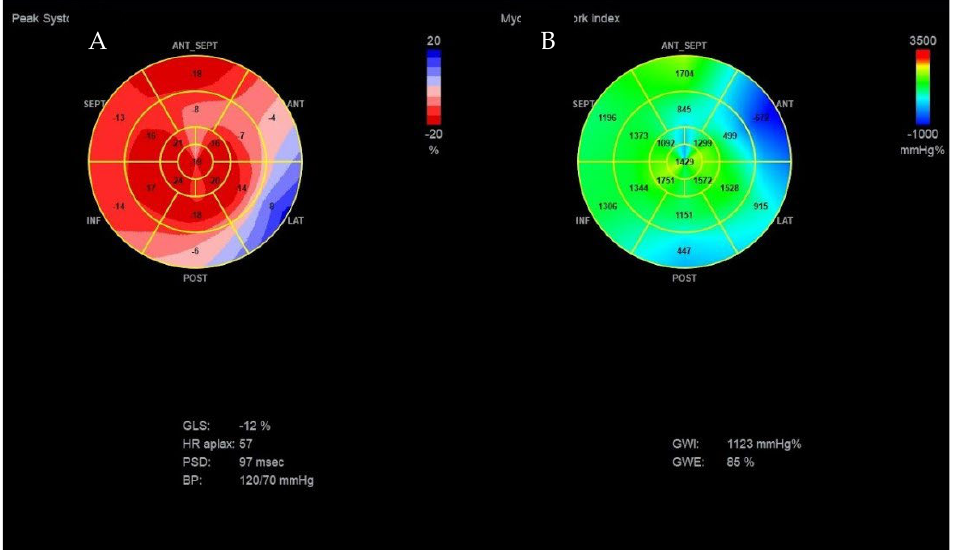
Figure 3. ( A ) Bull’s-eye polar map of left ventricular global longitudinal strain. ( B ) Myocardial work index, and efficiency .